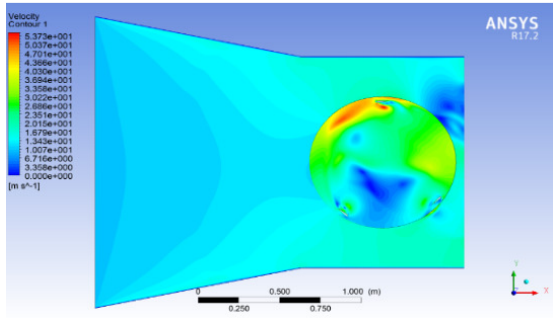
Fig .6. Pressure distribution along the different convergent duct .